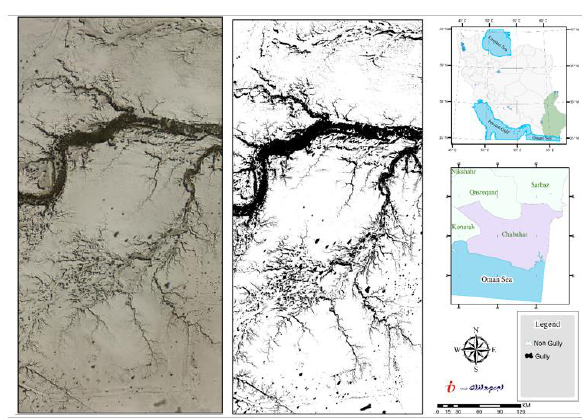
Figure 8. The binary result of classified gullies with machine-